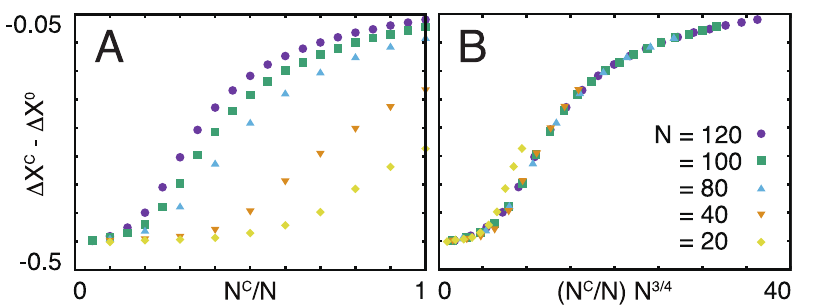
Fig 5. System-size dependence of the robustness. Dependence of Δ X C − Δ X 0 on (A) N C / N and (B) ( N C / N ) N 3/4 for systems with various numbers of